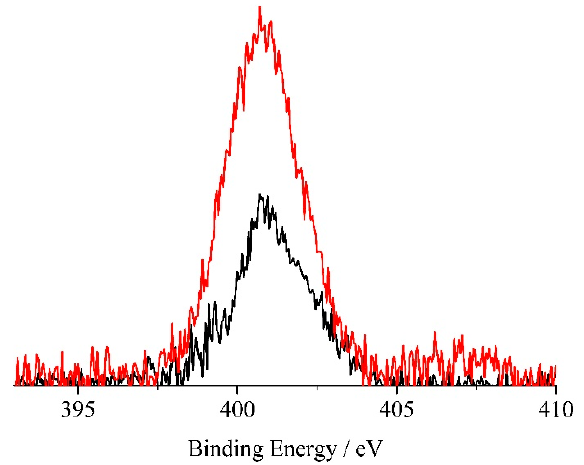
Figure 7. Al K α excited XPS of a representative PES electrospun mat with H 2 TPP before (black line) and after sensing of the p-NA (red line) in the N 1s binding energy region. The signal intensities have been normalized to results of the atomic concentration analysis.